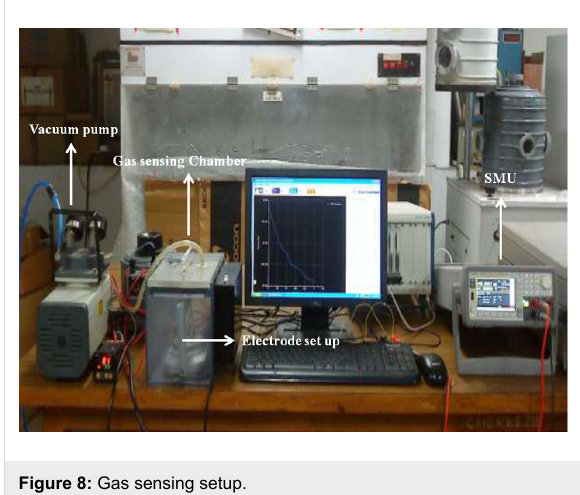
Figure 8: Gas sensing